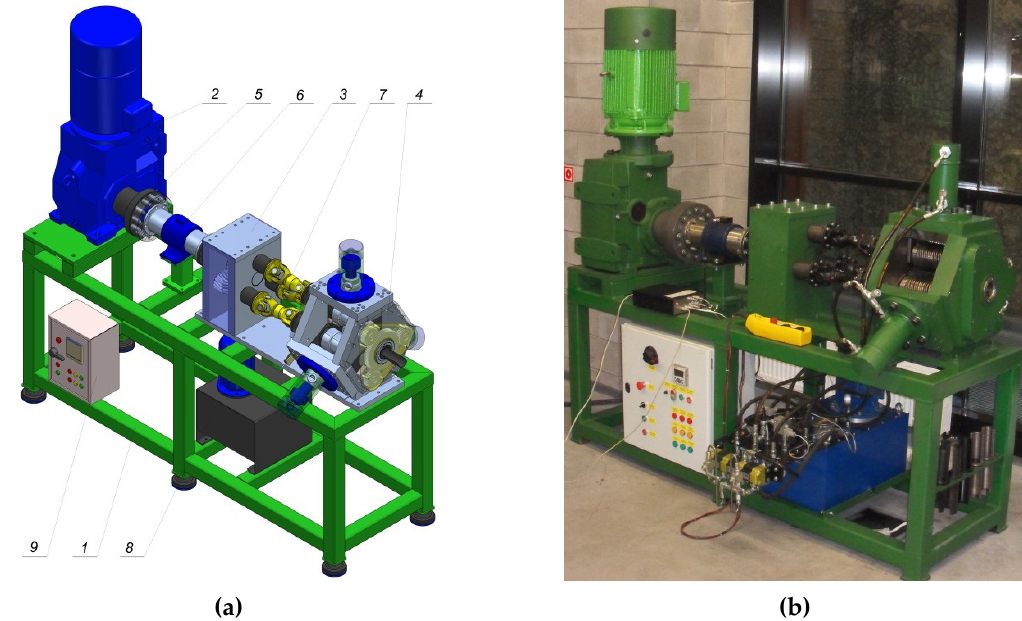
Figure 5. Forging machine for rotational compression: ( a ) 3D model; ( b ) photography of the machine; 1—carrier frame, 2—power unit, 3—toothed roll stand, 4—forming roll stand, 5—flexible coupling, 6—torque measurement system, 7—jointed shafts, 8—hydraulic drive, 9—power box.